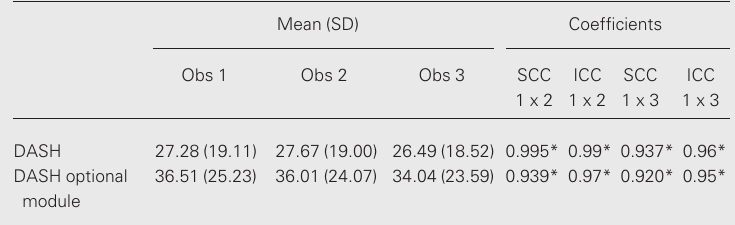
Table 2. Inter- and intra-observer reliability determined by Spearman’s correlation coefficient and the intraclass correlation coefficient, showing the mean Disabilities of the Arm, Shoulder and Hand (DASH) scores obtained by two observers and for the assessment performed one week later in 40 patients with rheumatoid